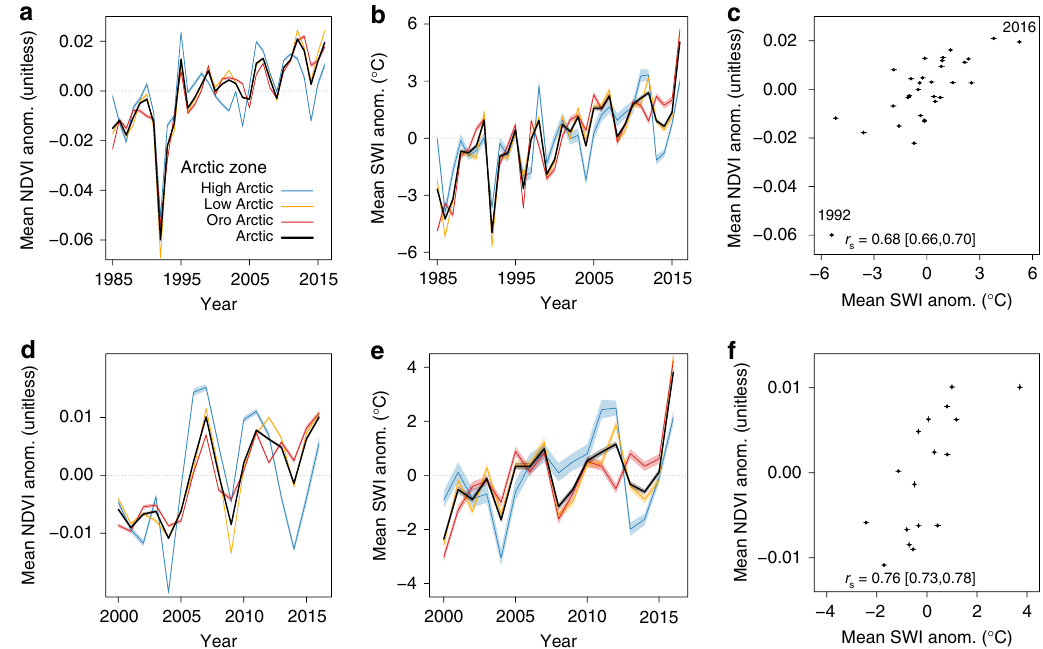
Fig. 2 Tundra greenness and summer air temperature time series and covariation. Left panels show changes in mean Landsat NDVI max [unitless] anomalies for the Arctic and each zone from 1985 to 2016 ( a ) and 2000 to 2016 ( d ). Middle panels show changes in mean summer warmth index [SWI; °C] anomalies from 1985 to 2016 ( b ) and 2000 to 2016 ( e ) derived from fi ve temperature data sets. Right panels show the relationship between mean Arctic NDVI max and SWI anomalies from 1985 to 2016 ( c ) and 2000 to 2016 ( f ). Spearman ’ s correlation coef fi cients ( r s ) relating NDVI max and SWI are provided for each period. Narrow error bands and whiskers depict 95% con fi dence intervals derived from Monte Carlo simulations ( n = 10 3 ). Note that while mean SWI time series are based on pan-Arctic data, the NDVI max time series, and NDVI max – SWI relationships are based on sites where Landsat data were available from 1985 to 2016 ( a , c ) and 2000 to 2016 ( d , f ), as shown in Fig.